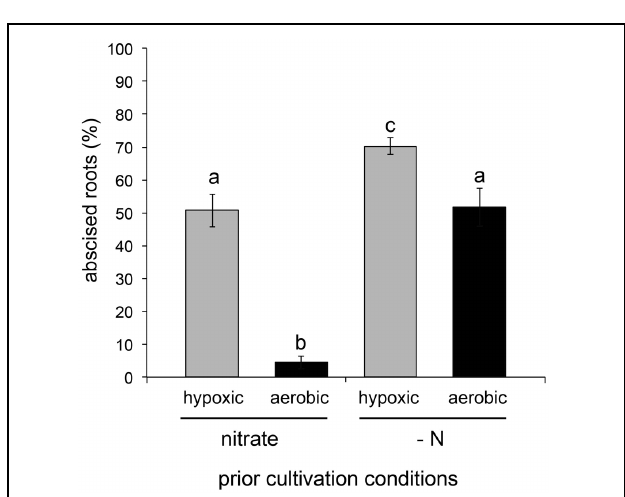
FIGURE 3 | Effect of hypoxia on abscission induced by 2 mM nitrite treatment of plants with or without prior cultivation in medium containing 5 mM nitrate. Abscission under hypoxic or aerobic conditions was measured 150 min after addition of nitrite (means ± SE; hypoxia, n = 4; aerobic, n = 6).